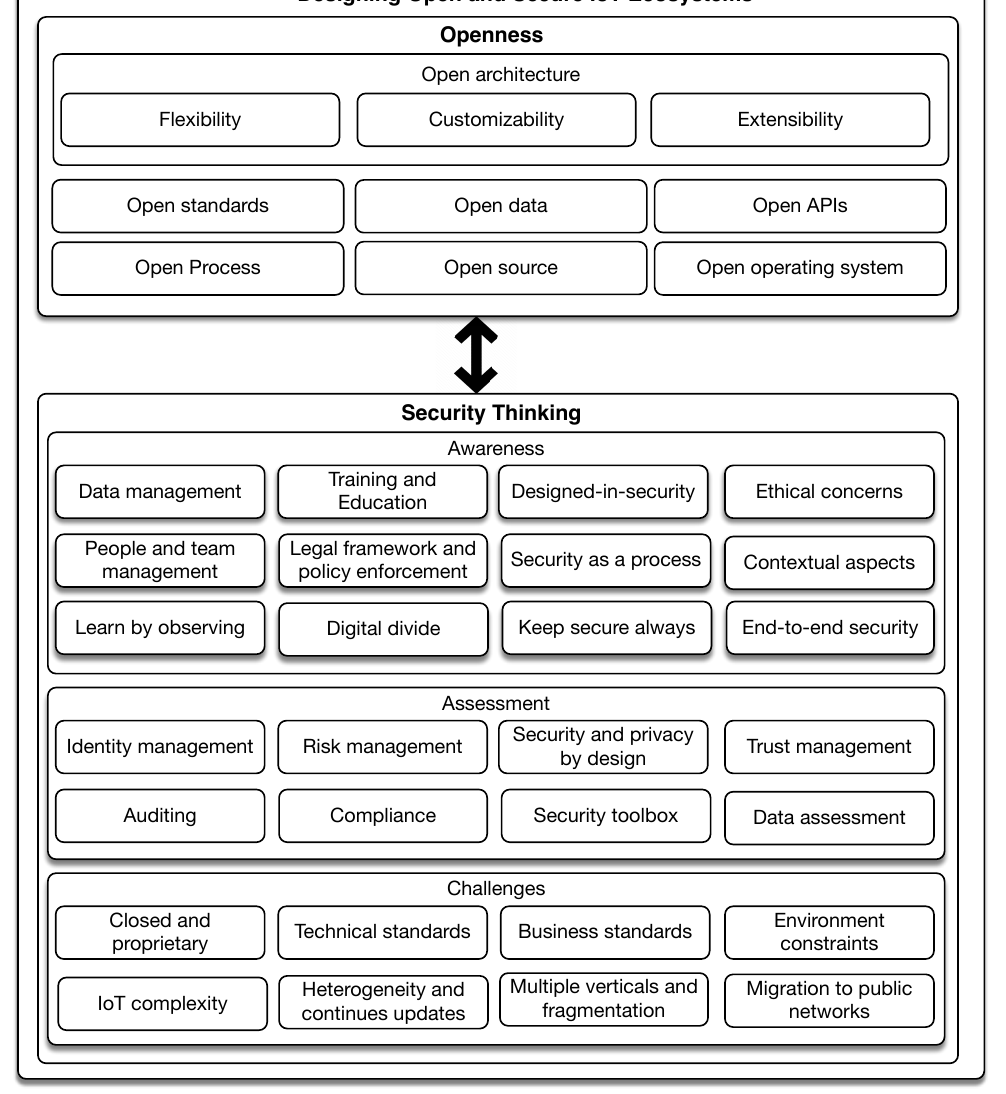
Figure 2. Open and Secure IoT design model